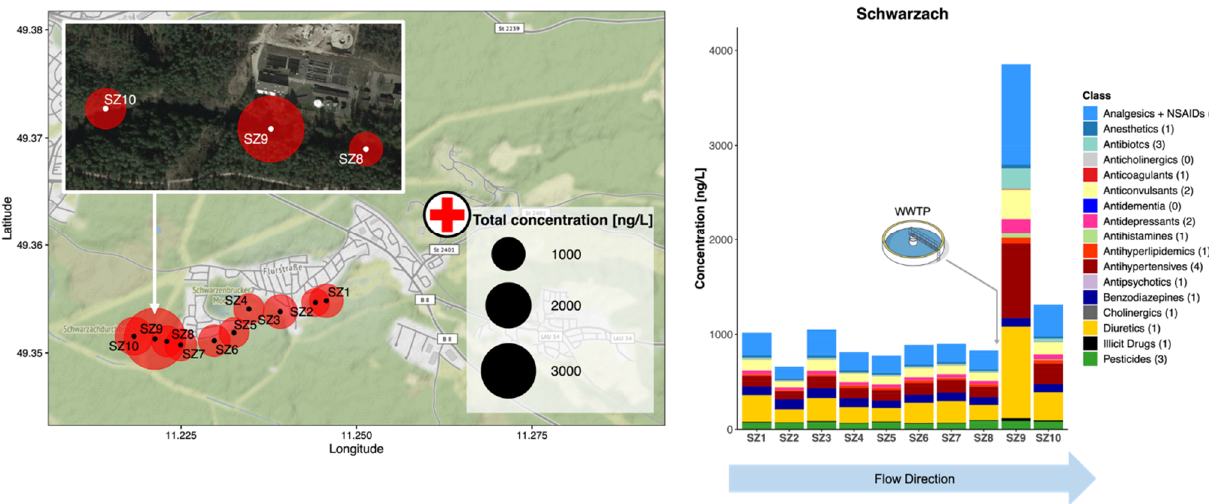
Figure 2. Occurrence of all CECs monitored in the River Schwarzach (SZ) in the Schwarzenbruck district, Bavaria, Germany, in grab samples taken in 2019. Red circles represent sampling points (labelled SZ1-10) and the size of the circle represents the combined total CEC concentration in ng/L. The hospital symbol represents the location of Rummelsberg Hospital. Individual compounds within each class can be found in Table S8.